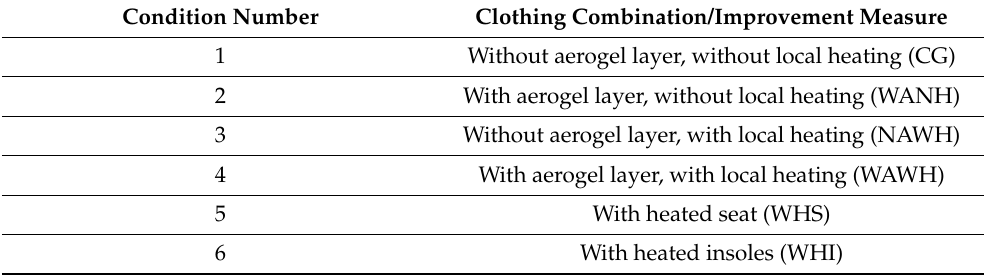
Table 2. Experimental conditions.